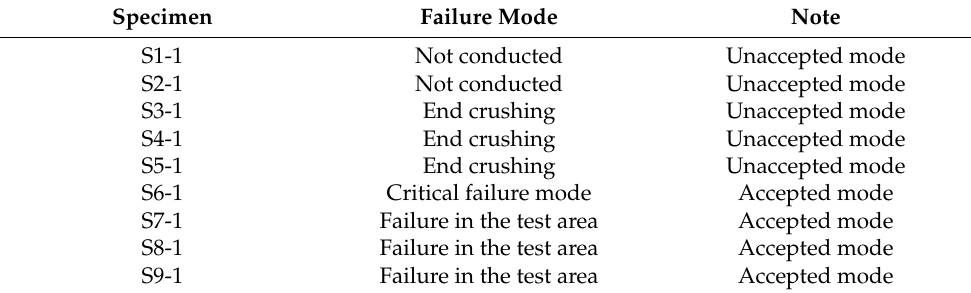
Table 2. Failure modes of specimens with 0° cracks. Figure 9. ( a ) C-scan results and ( b ) failure modes of specimens with 0° deep cracks after compression.